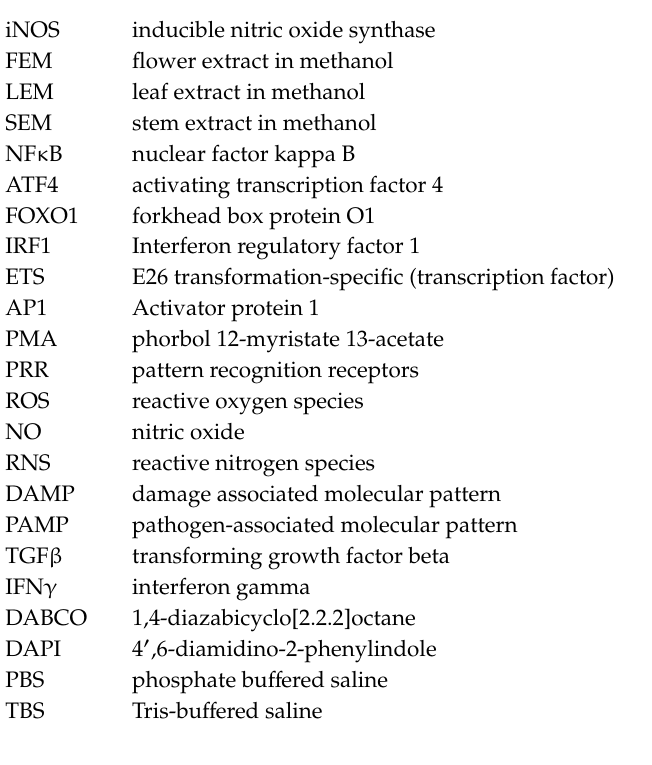
s1. Figure S1. Cytotoxicity of selected chemical substances present in S. acmella extracts on RAW macrophages. Figure S2. Confirmation of the cytoprotective e ff ect of spilanthol in RAW